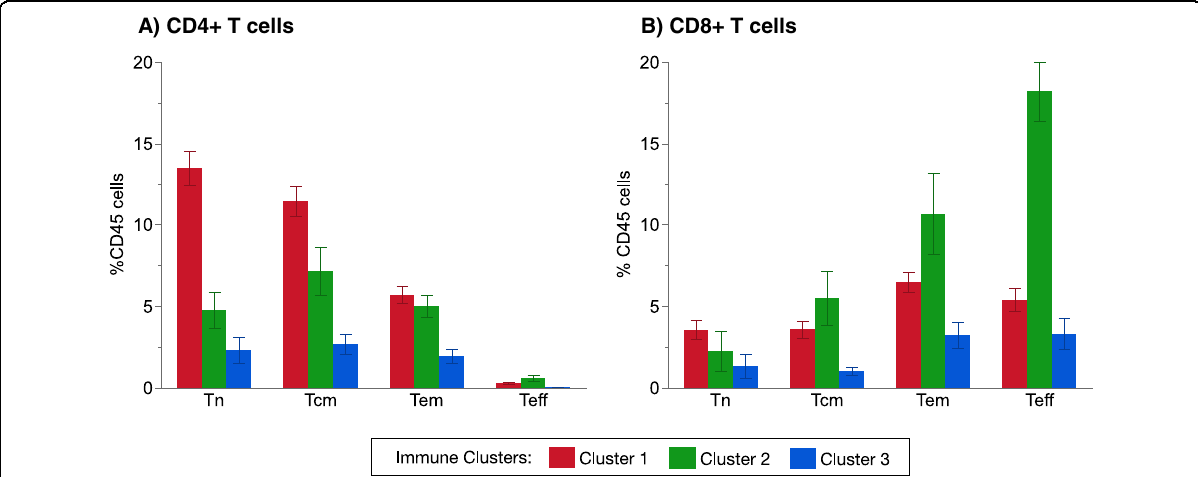
Fig. 4 Differential abundance of T-cell phenotypes within each patient cluster. CD4 + T-cell subsets are shown in ( A ), with the percentages of Tn (naïve T cells, comprising subsets T1 and T2), Tcm (central memory T cells, comprising of subsets T6 and T8), Tem (effector memory T cells, comprising of subsets T4, T7, T9), and Teff (effector T cells, comprising of the T10 subset). CD8 + T-cell subsets are shown in ( B ), with the percentages of Tn (naive T cells, comprising subsets T11 and T12), Tcm (central memory T cells, comprising of subsets T13, T14, T15), Tem (effector memory T cells, comprising ofsubsets T17, T18), and Teff (effector T cells, comprising of the subsets T16, T19, T20). Results are presented as mean ± standard error